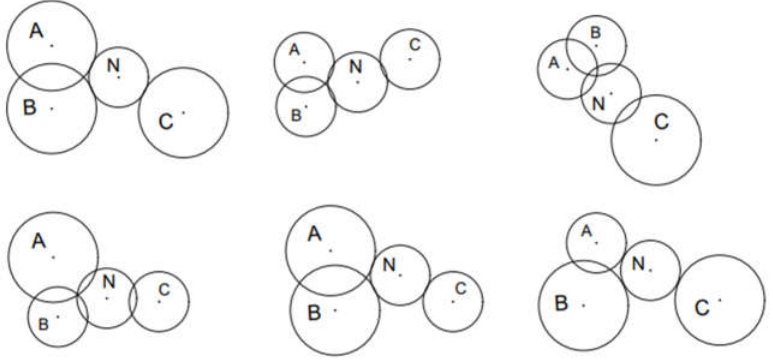
Figure 4. Nodes A and B intersect each other.